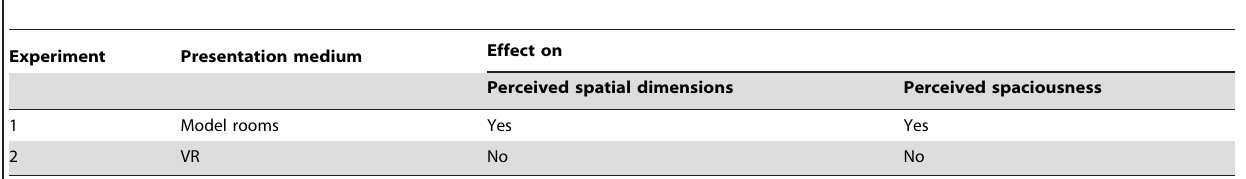
Table 6. Overview of the effects of furnishing on perceived spatial dimensions and perceived spaciousness of interior space in Experiments 1 and